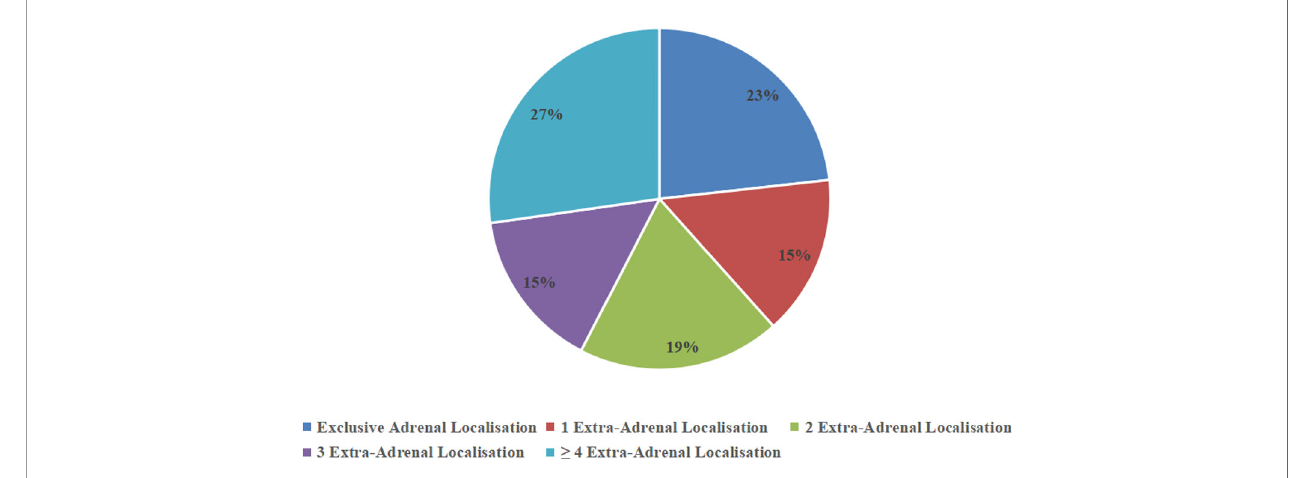
FIGURE 3 | Percentage of adrenal and extra-adrenal